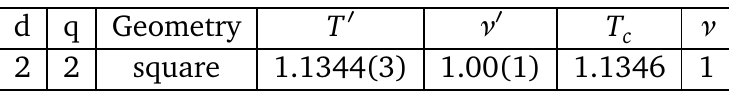
Table 2: Critical properties of the antiferromagnetic 2-state Potts model obtained using ANNs trained with MC data. The values of T (cid:48) and ν (cid:48) and their associated standard errors are estimated by finite-size scaling of ANN outputs. Literature values of T and ν are included for c